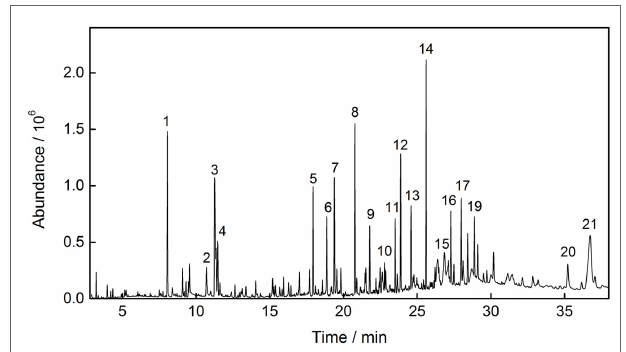
FigUre 1 | Total ion chromatogram of bio-oil from pine pyrolysis at 520°c